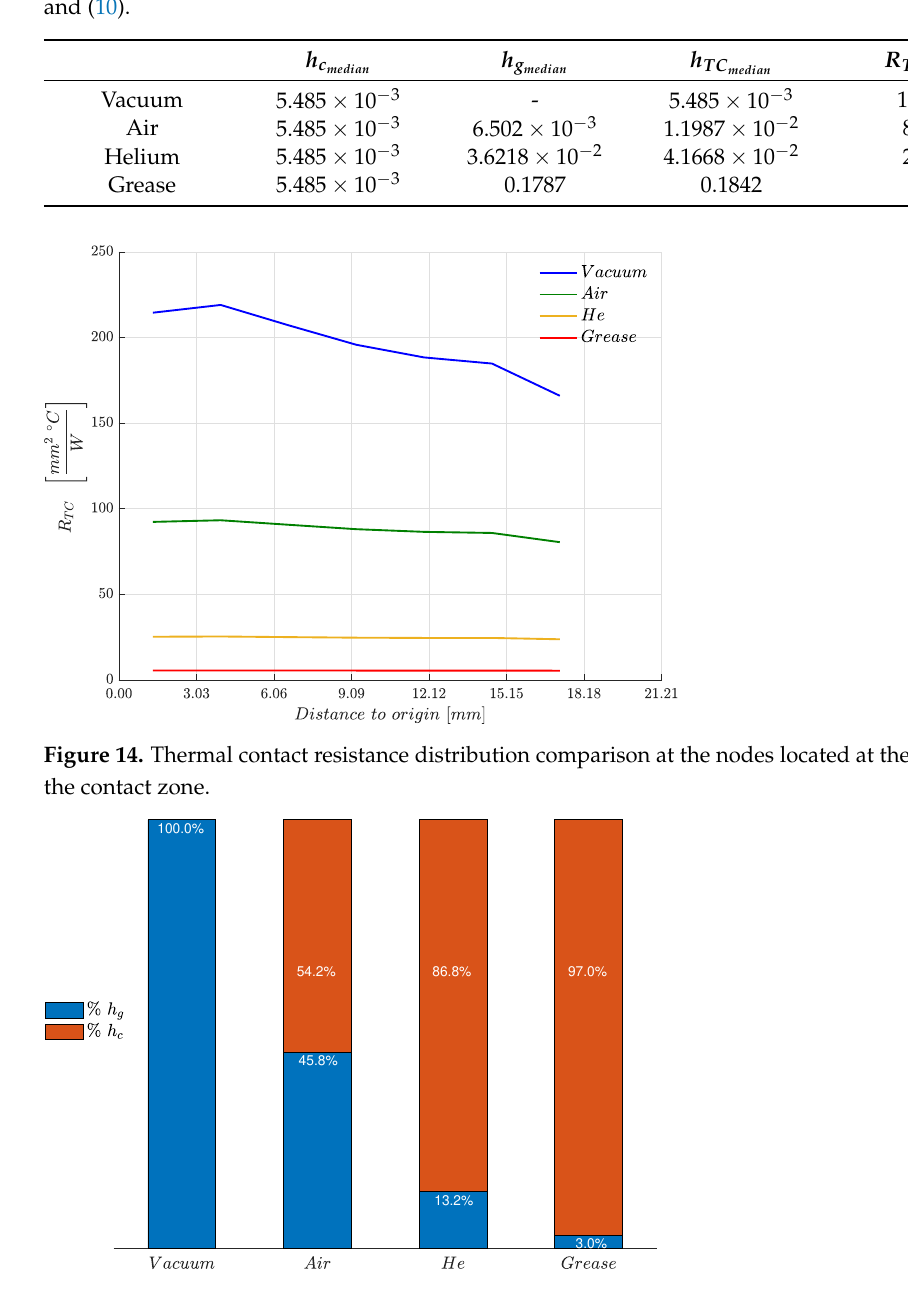
Figure 15. Microcontacts thermal contact conductance ( h c ) and TIM thermal conductance ( h g ) % comparison for all TIMs studied at the potential contact